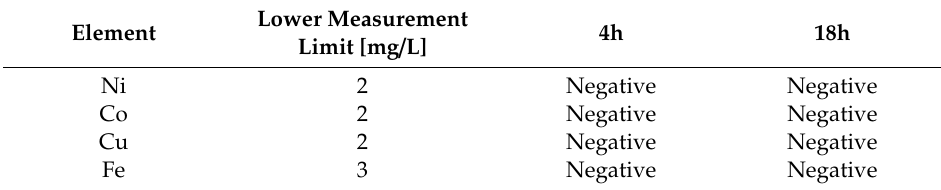
Table 7. Results of screening tests. Negative = not